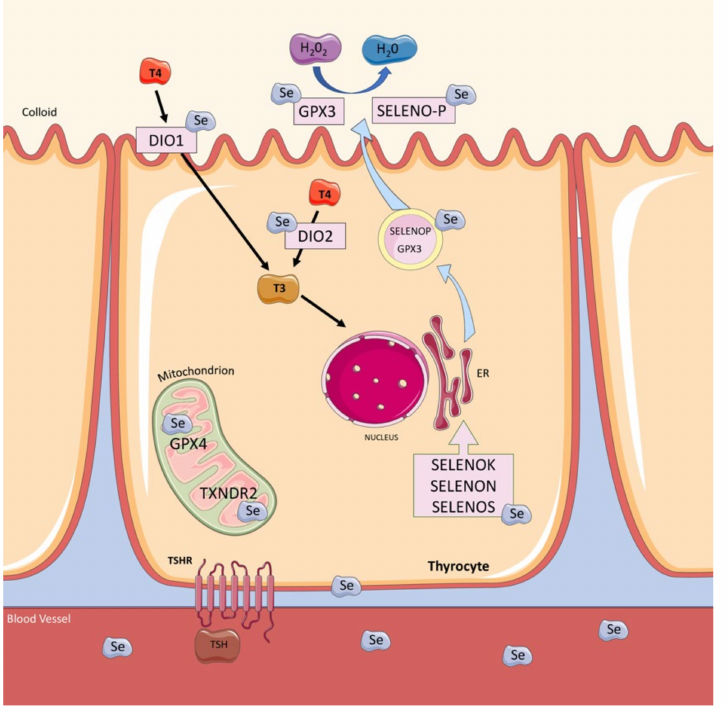
Figure 1. Thyroid gland selenoproteins. Selenoprotein P (SELENOP) and glutathione peroxidase 3 (GPX3) are actively secreted from the thyrocyte and exert oxidoreductase functions, protecting thyrocytes from excessive H 2 O 2 accumulation. Other selenoproteins, including Selenoprotein K, N, and S (SELENOK, SELENON, and SELENOS, respectively) take part in the quality control pathways within the endoplasmic reticulum. Type 1 (DIO1) and 2 iodothyronine deiodinase (DIO2) regulate thyroid hormone levels, converting T4 into T3. GPX4 and thioredoxin reductase 2 (TXNRD2) are localized in the mitochondria, affording protection against the hydrogen peroxide produced by the mitochondrial respiratory chain. This figure was created using Servier Medical Art templates, which is licensed under the Creative Commons Attribution 3.0 Unported License; https://smart.servier.com (accessed on 17 February